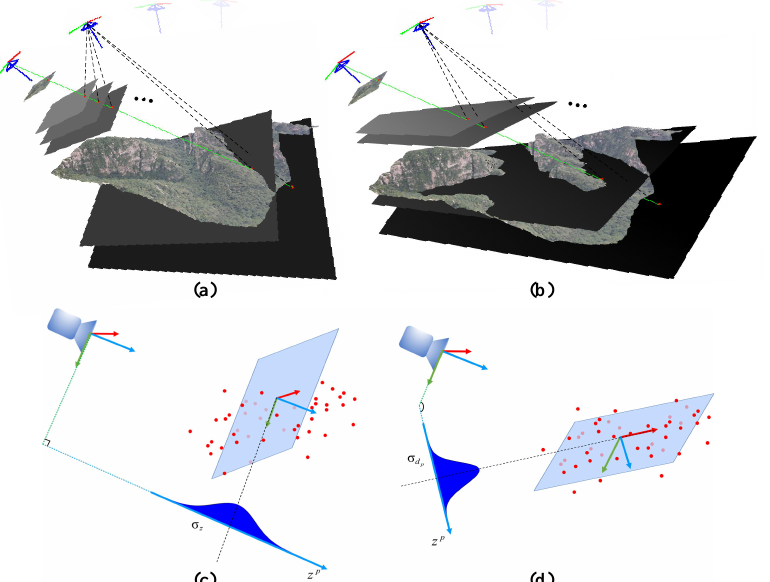
Figure 4. The gray plane in ( a ) is the selected searching plane, which is parallel to the imaging plane, and ( b ) shows the plane selected by our method. Gray scale value of the plane indicates depth value, the darker the point, the larger the depth z . The two different ways to select the searching plane can lead to different depth distributions along the search direction, as is demonstrated in ( c , d